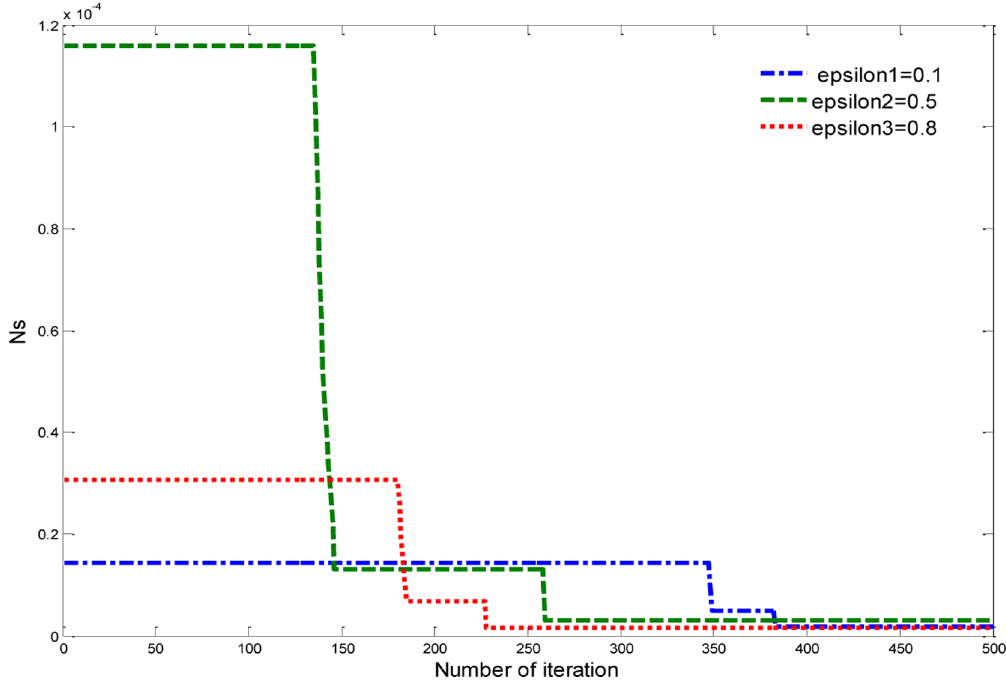
Figure 4. Effect of e on dimensionless total entropy generation rate ( Ns ) of RPF. doi:10.1371/journal.pone.0066080.g004 PLOS ONE |